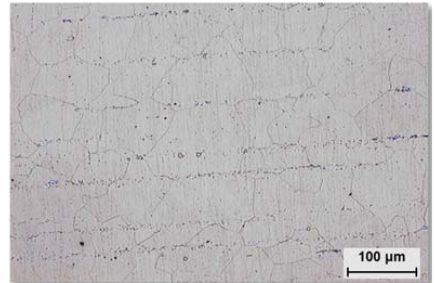
Figure 1. Microstructure of the cross-view of Alloy 617.